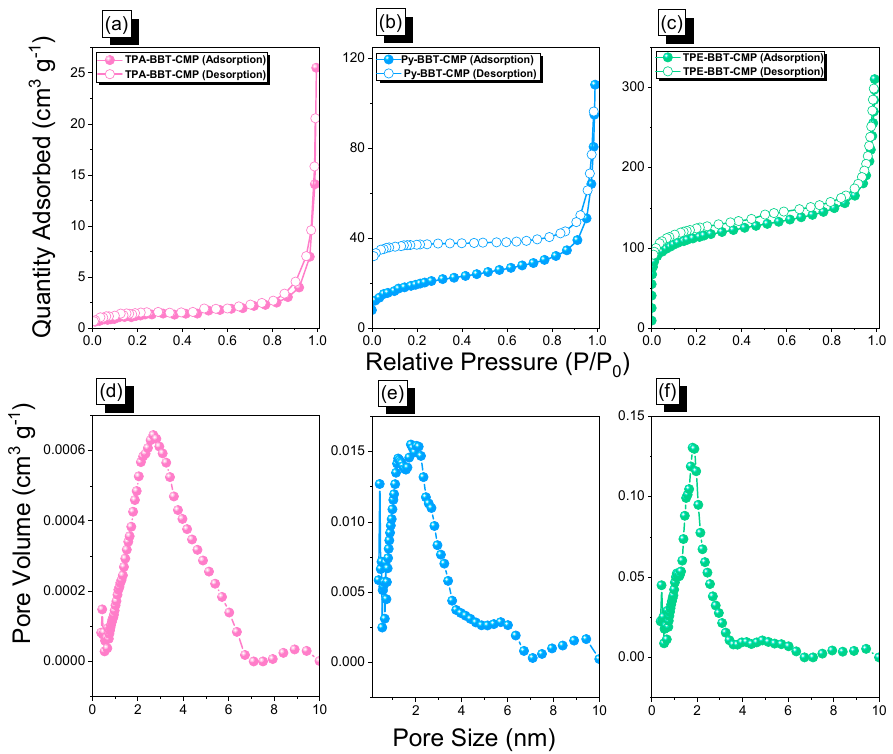
Figure 2. N 2 Uptake and pore size diameter curves of the TPA–BBT–CMP ( a , d ), Py–BBT–CMP ( b , e ), and TPE–BBT–CMP ( c , f ).